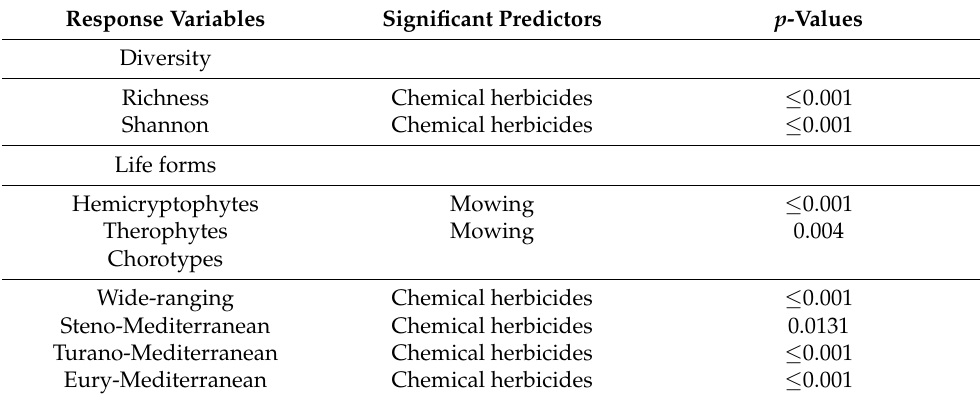
Table 2. List of the response variables with significant predictors and p -values after GLMM